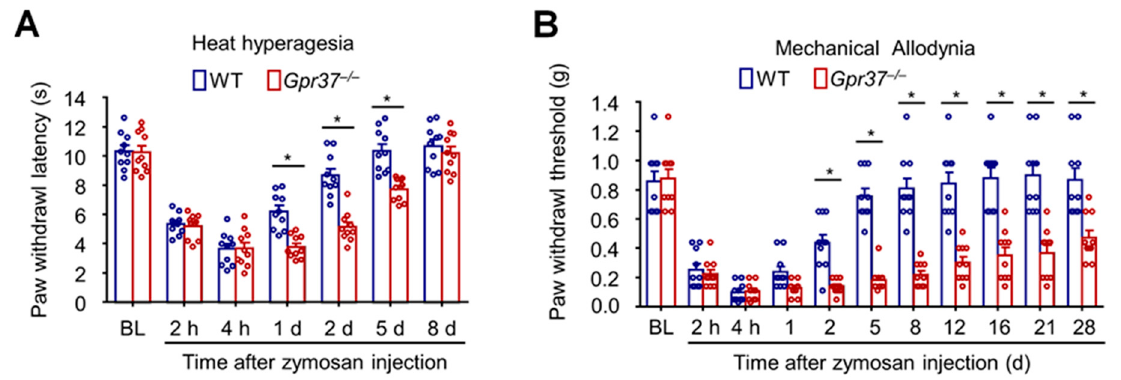
Figure 4. Zymosan-induced inflammatory pain in WT and Gpr37 KO mice. ( A ) Heat hyperalgesia. ( B ) Mechanical allodynia . Gpr37 –/– mice exhibit intact baseline pain, and the onset of inflammatory pain were also normal in these mice. However, the resolution/recovery phase of inflammatory pain was prolonged in KO mice. * p < 0.05, compared to Gpr37 –/– . The data were analyzed with two-way ANOVA. n = 10 mice per group. BL, baseline. These graphs are reproduced from Bang et al., JCI, 2018 with permission [35].